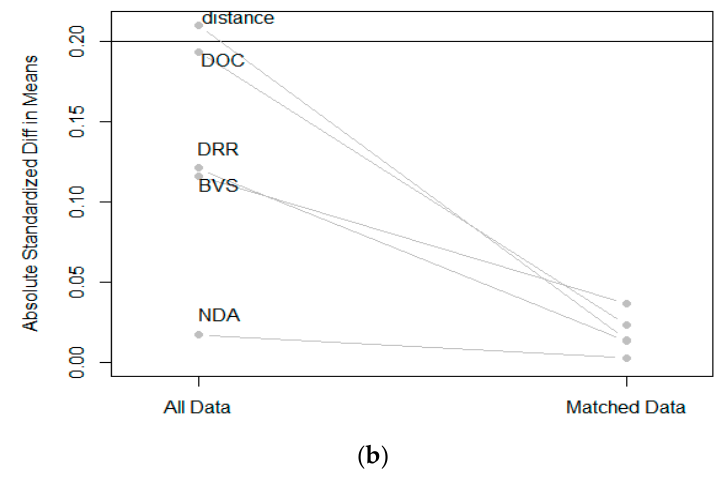
Figure 3. Distribution of Propensity Scores with the Experimental Data. ( a ) Diagnostics Graphical Plot, ( b ) Absolute Standard Difference Means.